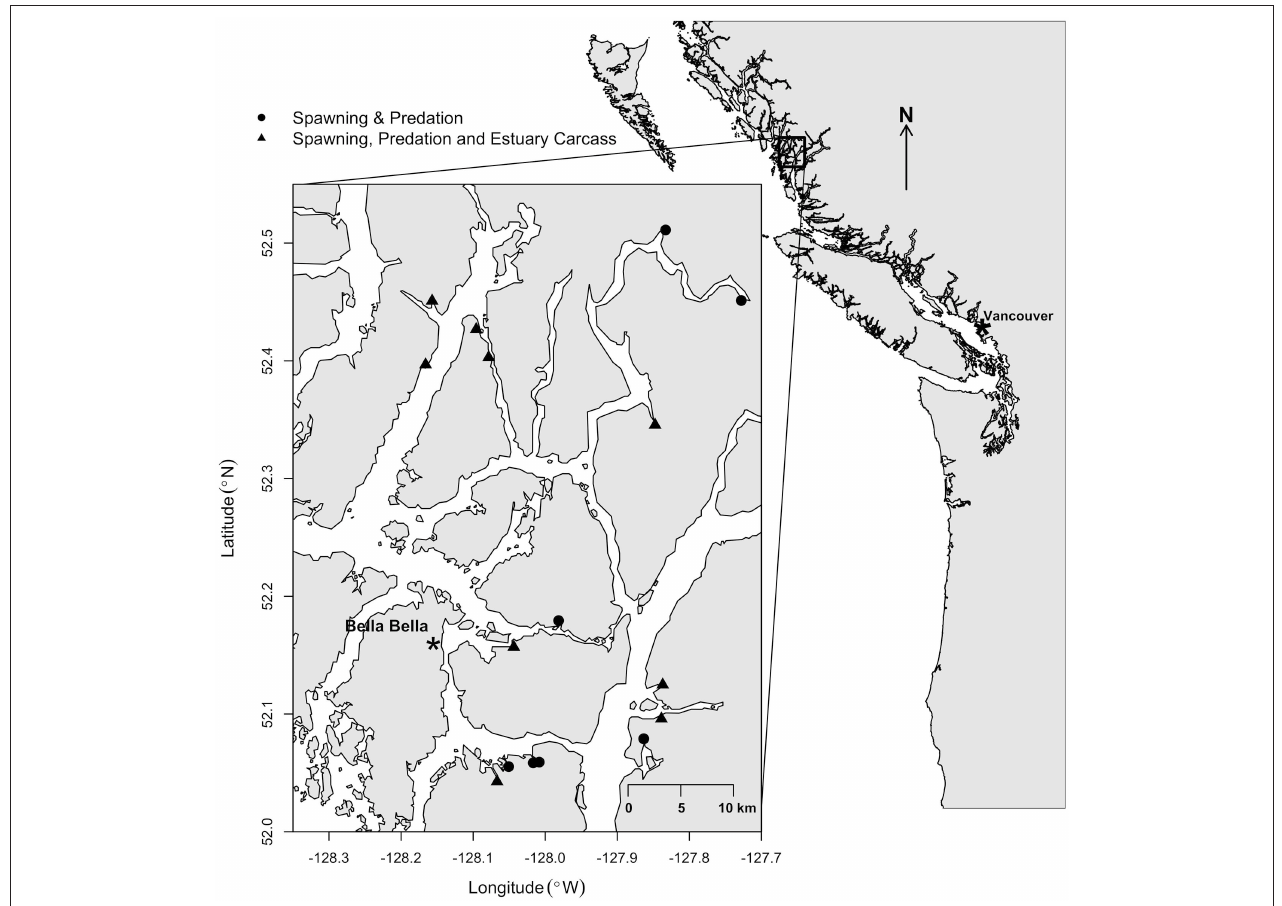
FIGURE 1 | Study area in the vicinity of Bella Bella on British Columbia’s central coast. Circles indicate spawning and carcass transfer study sites from 2009 to 2013; triangles indicate where estuary salmon carcasses were also counted in 2008 and 2009.